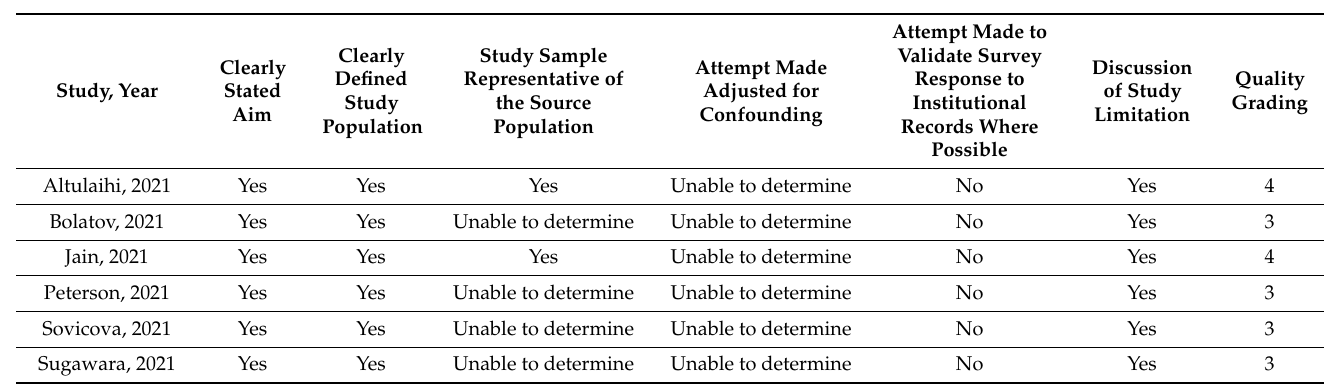
Table 1. Characteristics of